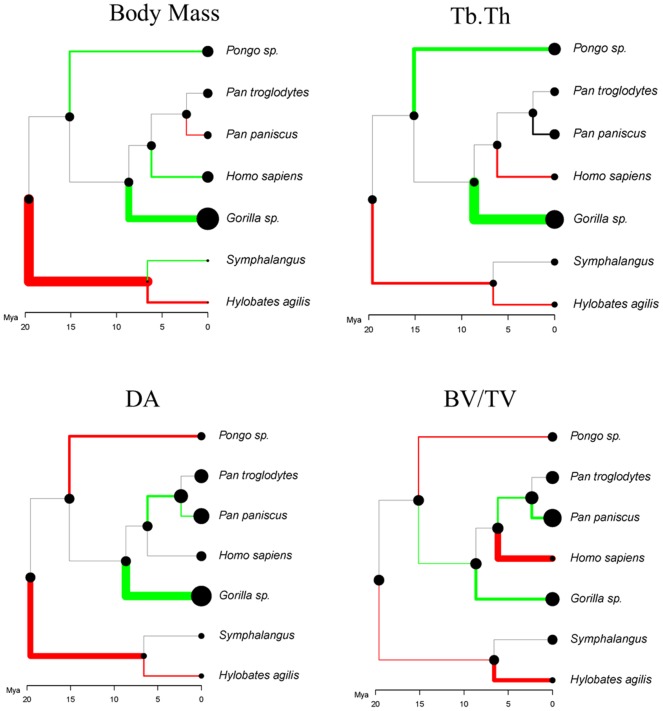
Phylogenetic reconstructions of evolutionary changes in body mass and trabecular bone parameters.Taking into account the divergence dates of the hominoid linage, these evolutionary reconstructions show how body mass, trabecular thickness (Tb.Th), bone volume fraction (BV/TV), and degree of anisotropy (DA) are estimated to have changed over time based on the trabecular structure present in extant hominoid metacarpals. The x axis represents time in millions of years (Mya). Green represents an increase and red a decrease, the thickness of the line reveals the rate of change.